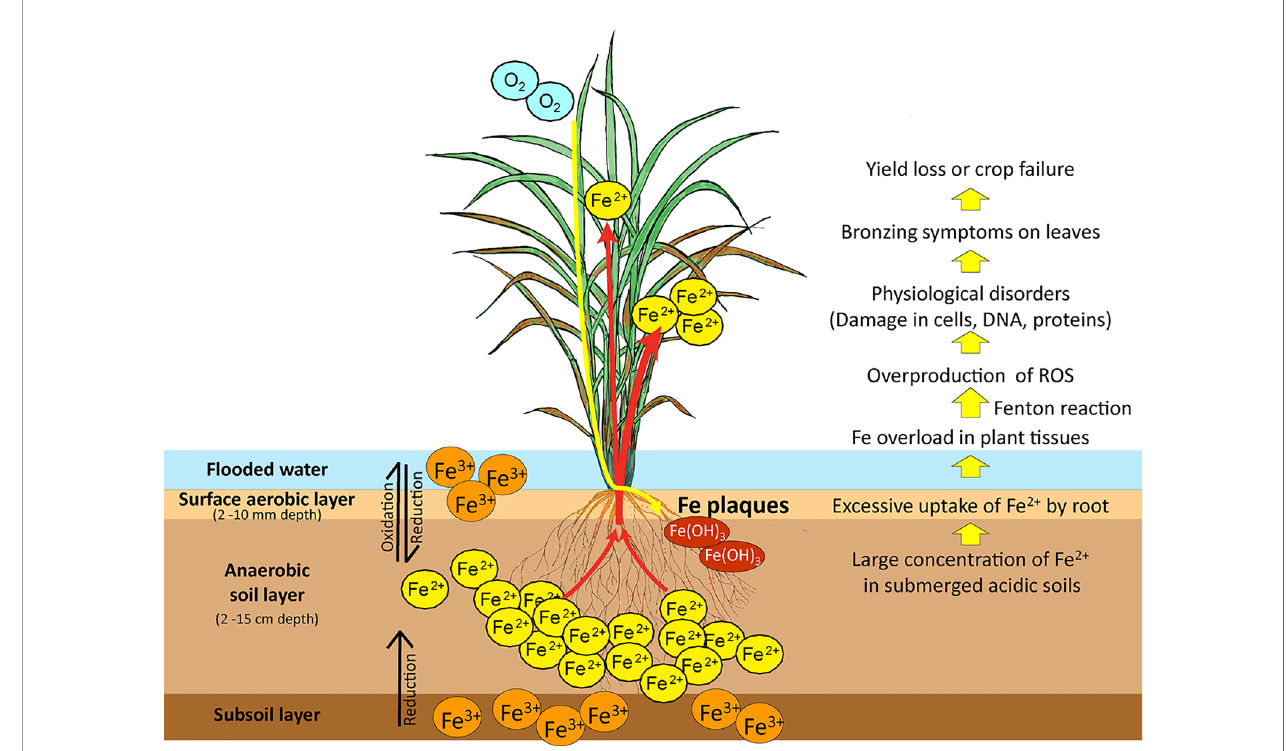
FIGURE 1 | Iron reduction in submerged low-pH soils and the effects of Fe toxicity on rice plants. In submerged soils with anaerobic and low pH conditions, ferric ion (Fe 3+ ) is reduced to the more soluble ferrous ion (Fe 2+ ). Excess ferrous ion is absorbed by the roots and transported by the xylem to the leaves, causing Fe overload in plant tissues. Excessive Fe accumulation in plant tissues causes overproduction of ROS by the Fenton reaction. These damage cellular structures, membranes, DNA, and proteins and impair physiological processes. Fe toxicity causes bronzing symptoms in leaves, followed by loss of rice yield or complete crop failure. Fe 3+ , sparingly soluble ferric ion; Fe 2+ , soluble ferrous ion; ROS, reactive oxygen species. Red arrows: Fe uptake and transport by rice; Yellow arrow: Rhizospheric oxidation of Fe 2+ to Fe 3+ by oxygen transport from shoot to root, leading to formation of Fe plaques on the root